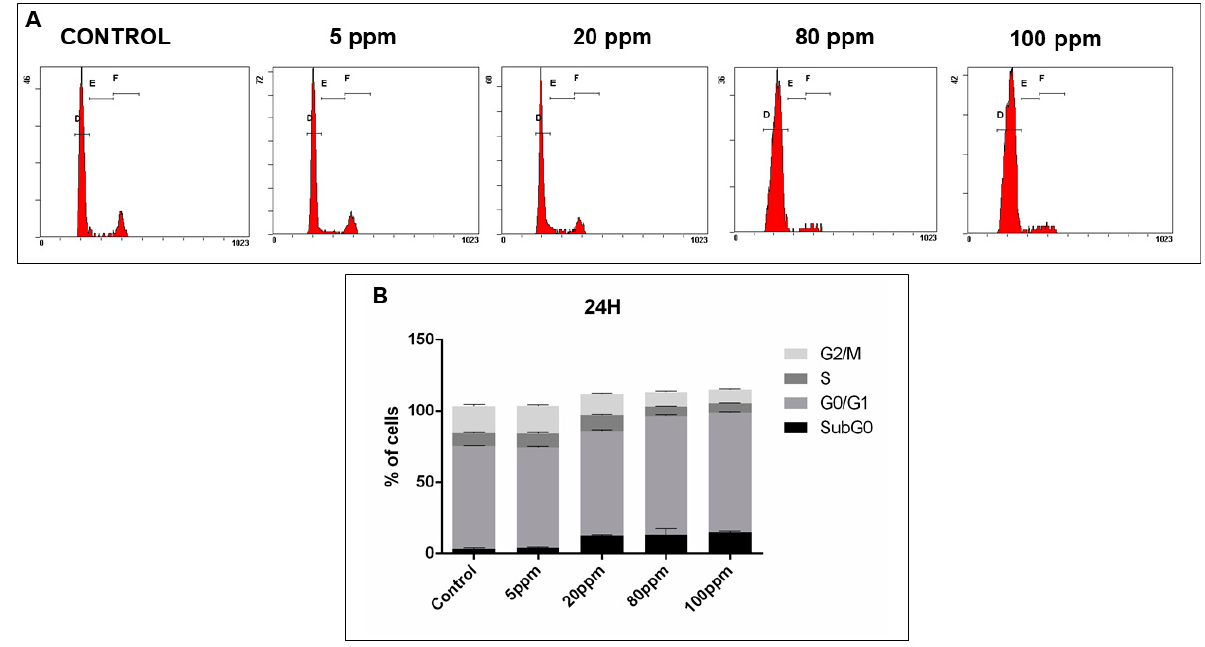
Figure 10. Cell cycle analysis, of LNCaP cells treated with different concentrations of AgNPs for 24 h, assessed using a PI stain and flow cytometry. ( A )—Representative DNA histograms. ( B )—Quantitative analysis of PC-3 cells AgNPs treated. Data is expressed as mean ± SEM.